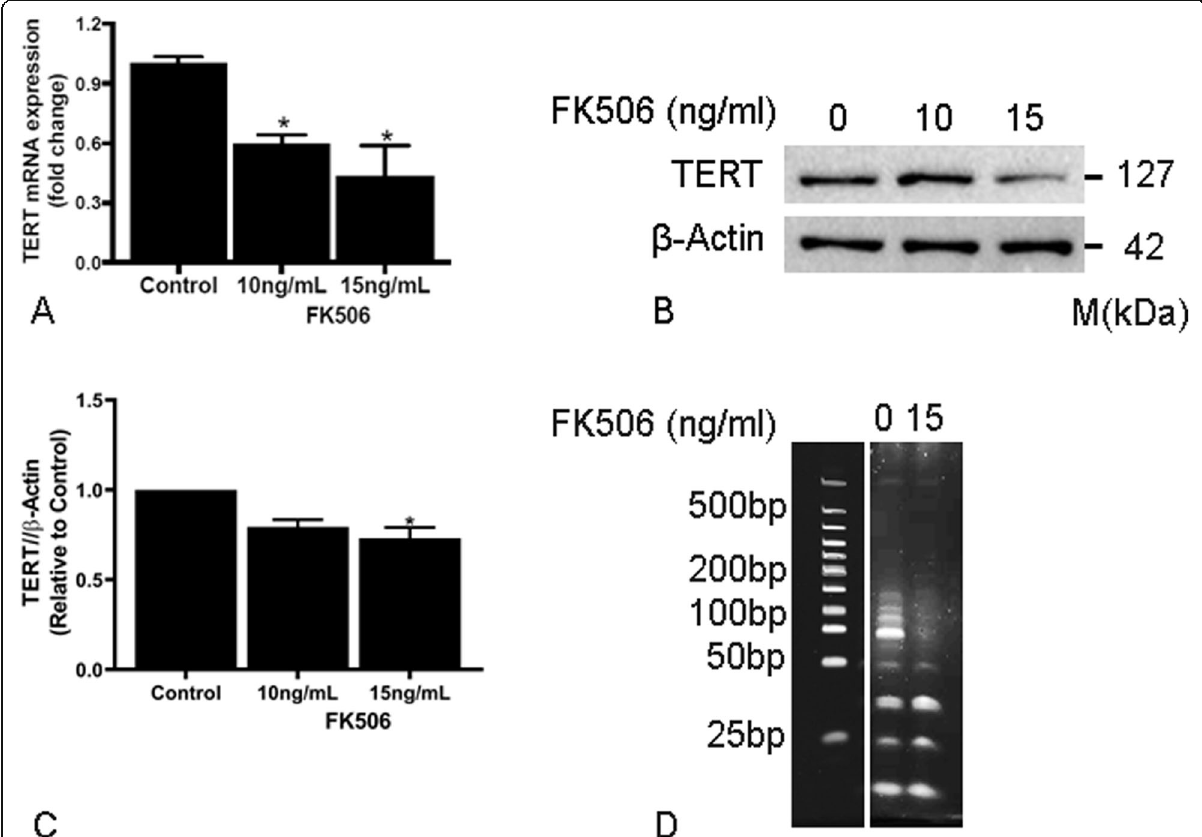
Fig. 1 FK506 decreases TERT mRNA and protein levels with resulting decrease in telomerase activity. Lung lymphatic endothelial cells were treated for 48 ( a, d ) or 72 h ( b ). ( a ) Real-time PCR analysis of TERT mRNA in control and FK506-treated lung lymphatic endothelial cells. Results were expressed as the fold change compared to control. ( b ) Whole cell lysates were analyzed by Western blotting with antibodies against NFAT and TERT. ( c ) Ratio of TERT to β -actin density was expressed as fold change compared to control. Data represent mean ± SEM of 3 independent experiments (* p < 0.05) by one-way ANOVA; each independent experiment for western blotting consisted of one technical replicate. ( d ) Treatment with FK506 (15 ng/ml) resulted in decreased telomerase activity as assayed by the TRAP assay ( p < 0.05). Experiment was